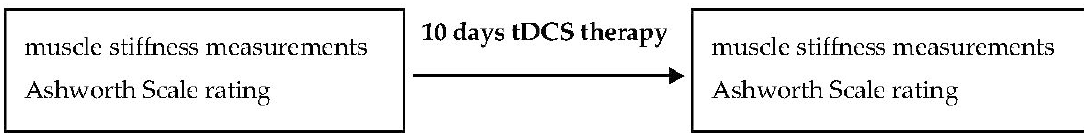
Figure 1. Experimental protocol.